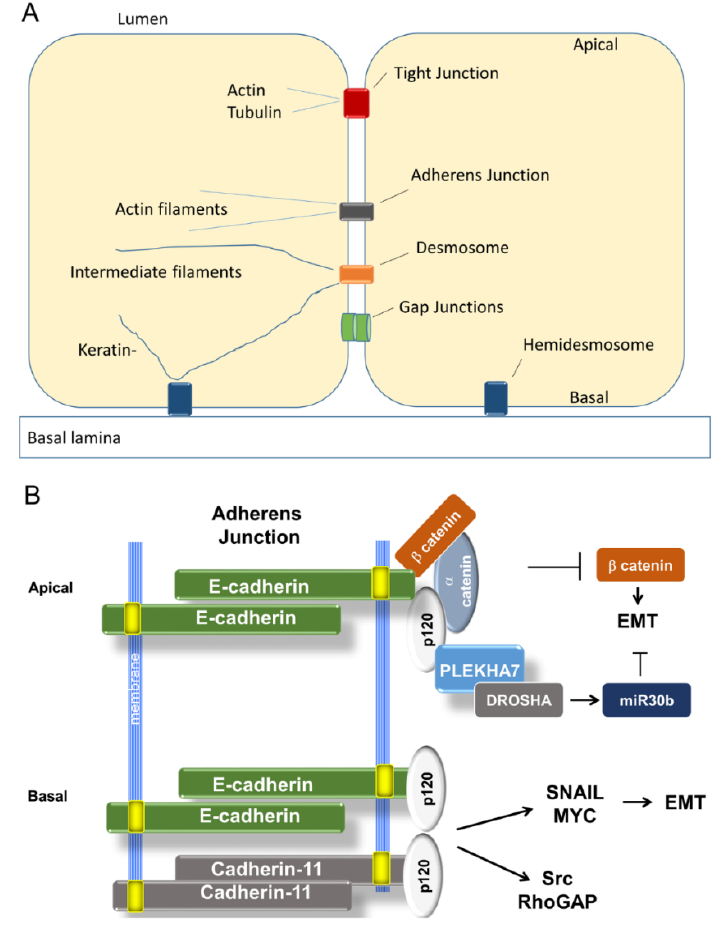
Figure 1. Epithelial junctions. ( A ) Generalized schematic showing types of cell–cell and cell ‐ matrix attachments of simple columnar epithelium. Except for gap junctions, each complex is linked both to cytoskeletal elements and to its own signaling apparatus. ( B ) Regulation of EMT–MET (epithelial ‐ to ‐ mesenchymal transition–mesenchymal ‐ to ‐ epithelial transition) by Adherens Junctions, adapted from Kourtidis et al. [65]. Canonically, E ‐ cadherin sequesters β‐ catenin and downregulates Twist. More recently, E ‐ cadherin was found to participate in two functionally distinct complexes, an apical one that opposes EMT and a basal one that promotes it. Apically, it interacts with PLEKHA7 and a microRNA processing complex that suppresses proliferation and mesenchymal functions. However, in basolateral locations it actually promotes those functions. This may explain the inconsistent patterns of E ‐ cadherin expression across breast cancer subtypes and the observation that it sometimes seems to promote invasion/metastasis rather than suppress it. For simplicity, E ‐ cadherin and cadherin ‐ 11 are shown as monomers and cytoskeletal interactions are omitted.